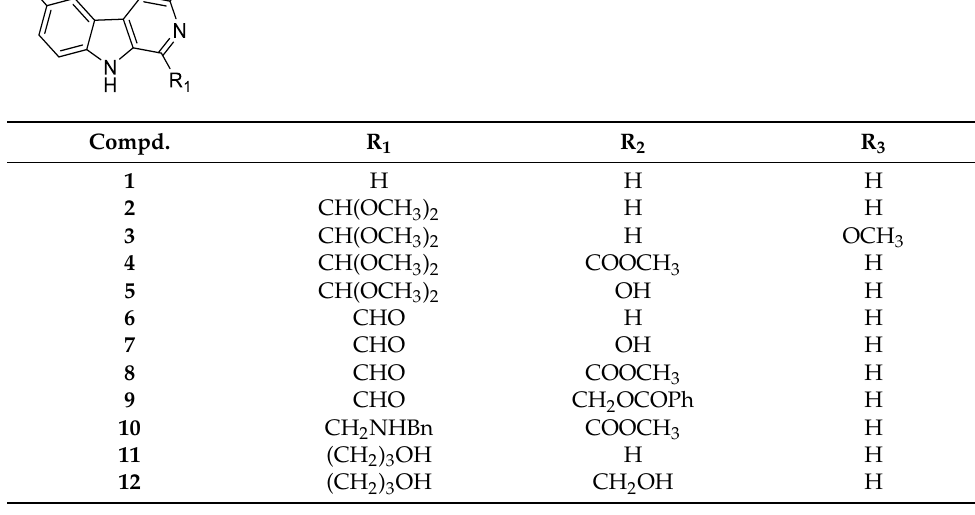
Table 1. β -Carboline derivatives used in this study.